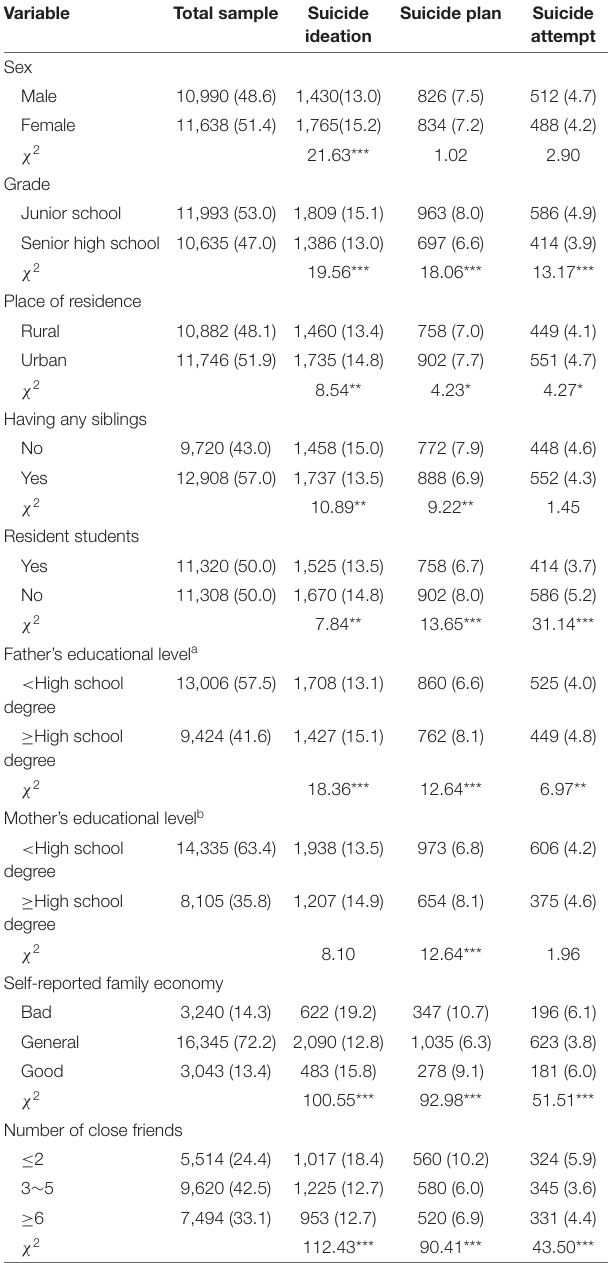
TABLE 1 | Descriptive socio-demographic characteristics of the sample in the study, n (%).